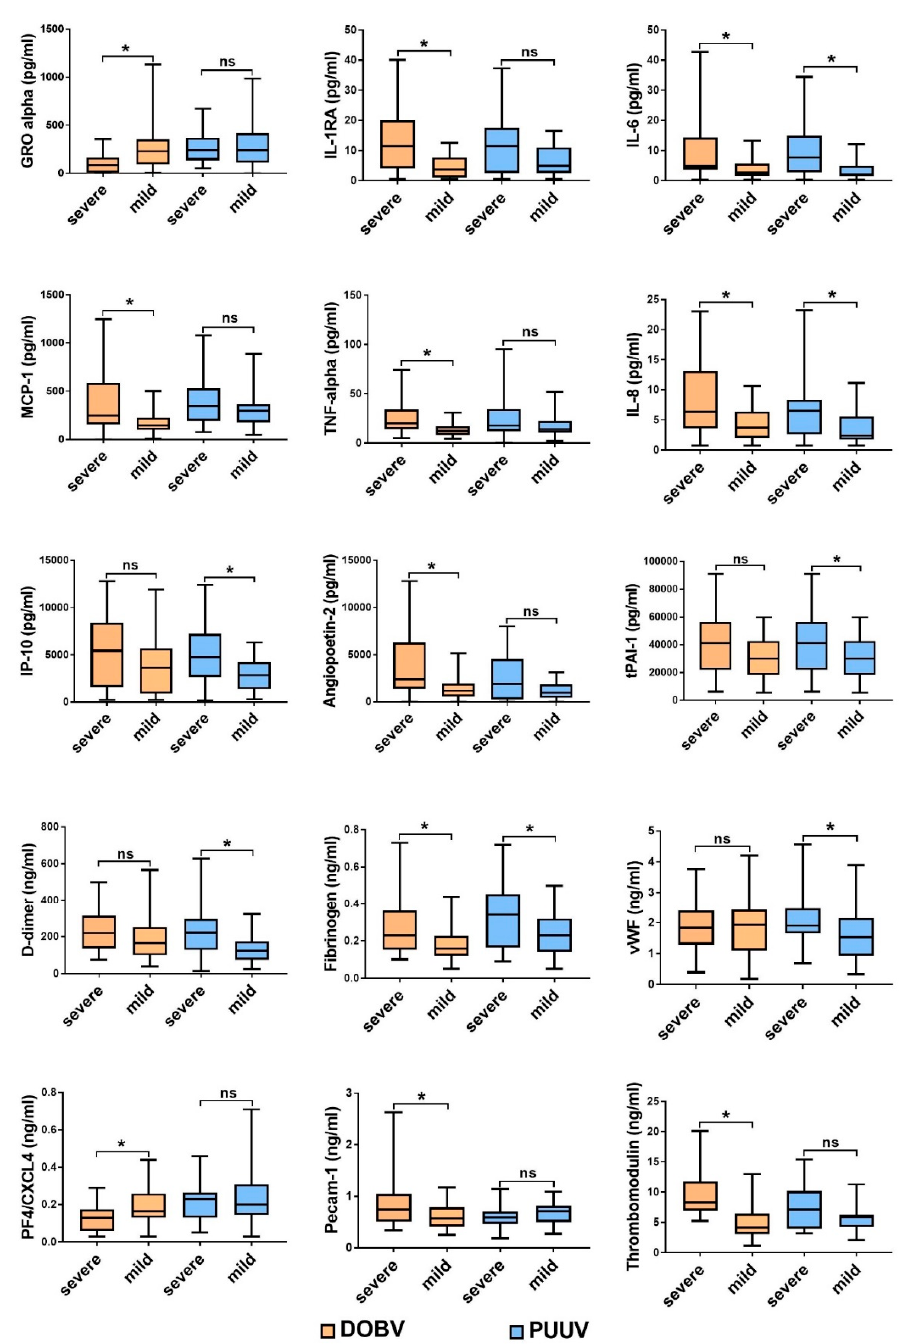
Figure 2. The cytokine and chemokine concentrations with significant differences in patients infected with DOBV (severe n = 25; mild n = 25) or PUUV (severe n = 25; mild n = 25), with regard to the disease progression and outcome. The statistically significant differences are marked with * ( p < 0.05). ns = not statistically significant. The boxes represents medians with interquartile ranges; the whiskers depict minimum and maximum values (range). Identified outliers are not included in the figures above: IL-6 (DOBV severe n = 4; DOBV mild n = 1; PUUV severe n = 1; PUUV mild n = 4), MCP-1 (DOBV severe n = 1; DOBV mild n = 4; PUUV severe n = 5; PUUV mild n = 4), IL-8 (DOBV severe n = 5; DOBV mild n = 3), D-dimer (PUUV mild n = 3), Fibrinogen (DOBV severe n = 5; DOBV mild n = 1; PUUV mild n =